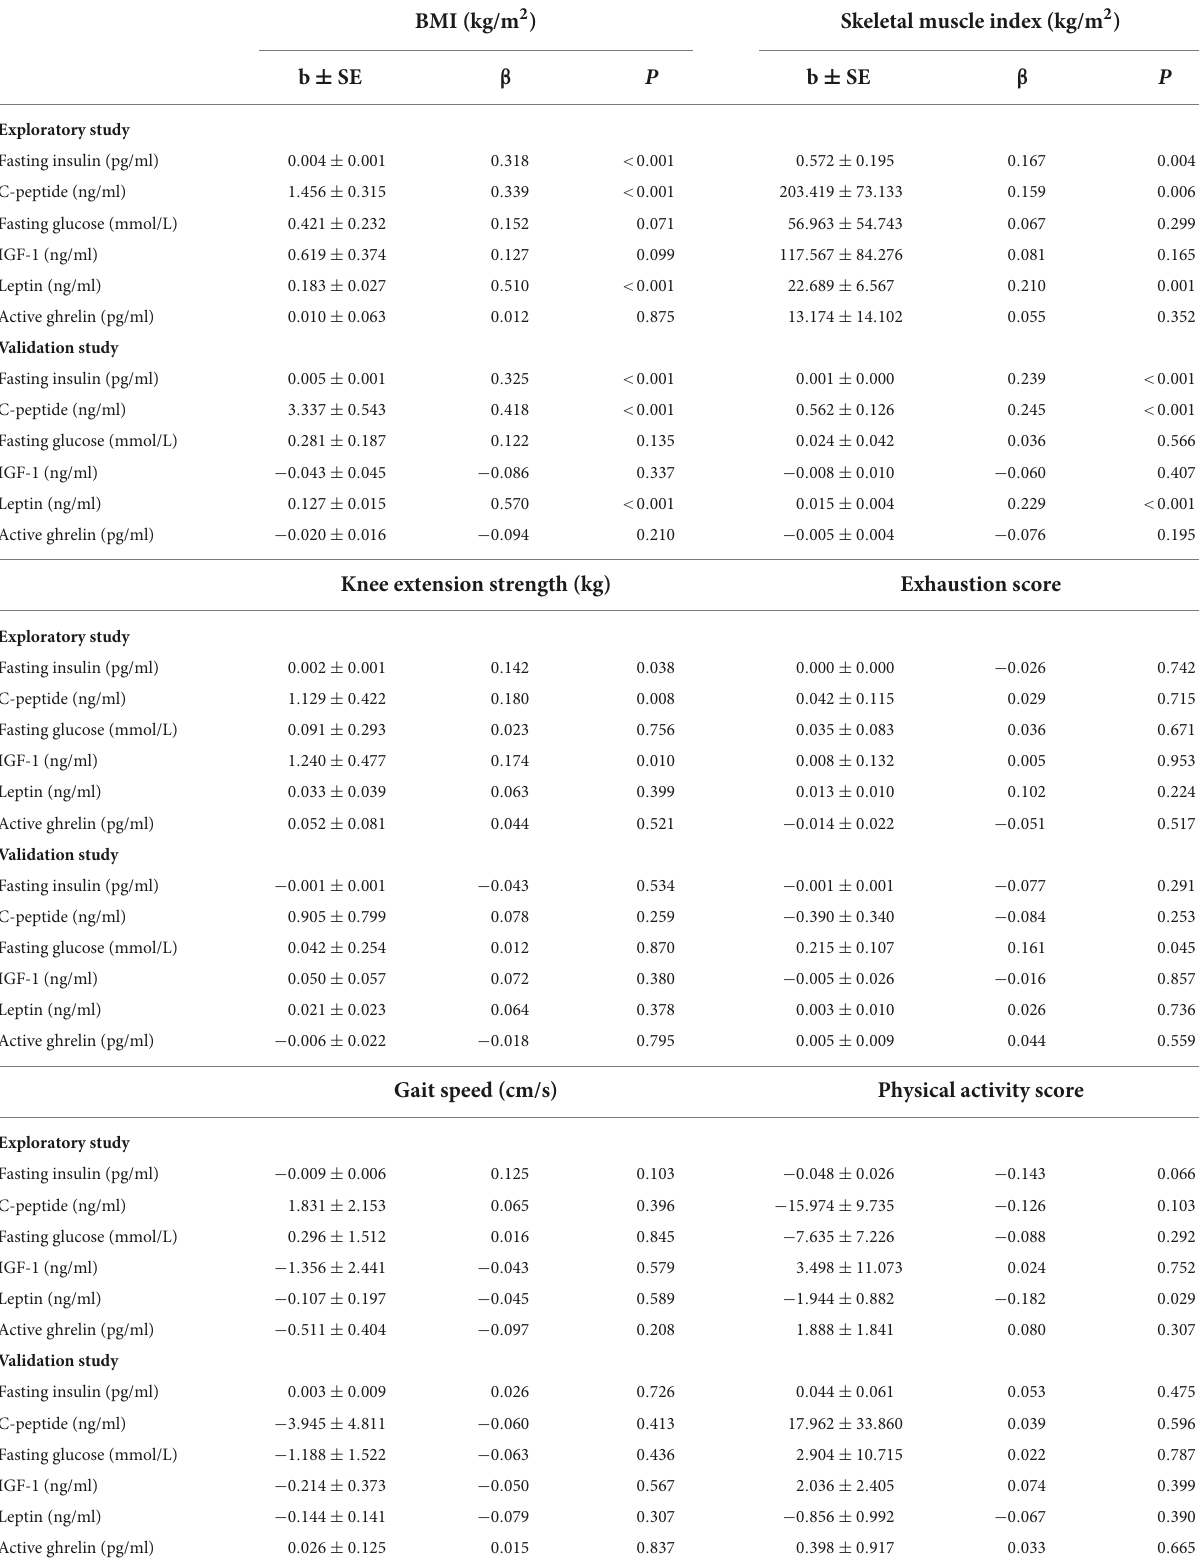
TABLE 4 Relations of blood biomarker concentrations to clinical and functional measures of sarcopenia and